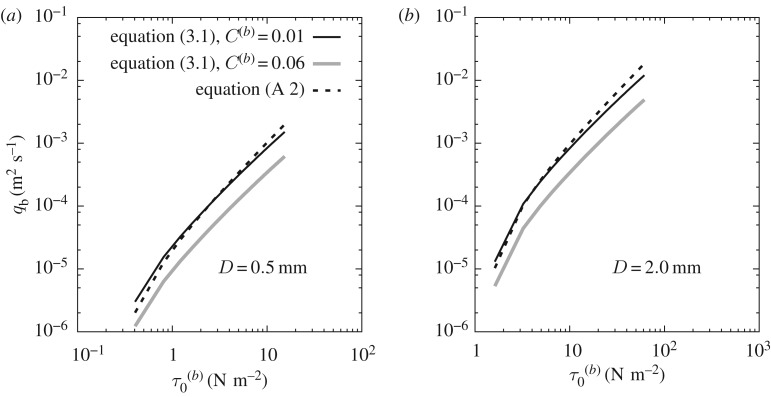
(a,b) Comparison between bedload predicted by qb=f(us0) (equation (.2)) and qb=f(u0) (equation (3.1)) for two values of C(b) and for two different particle diameters: (a) medium sand; (b) coarse sand.